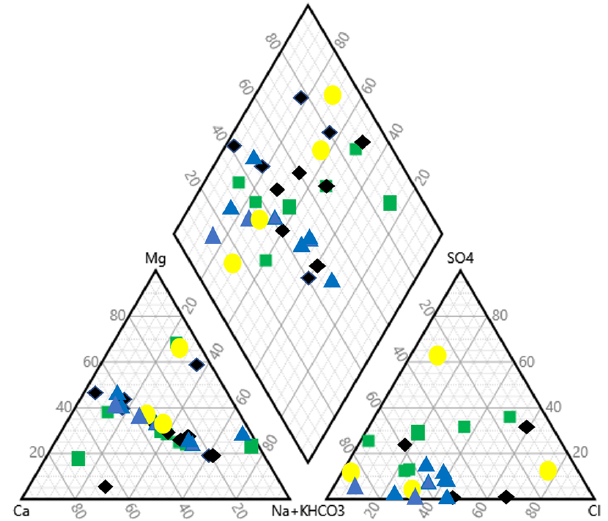
Figure 6. Piper diagram for the data collected in the sampling site, using HydroOffice software. Coloured in green the samples form Quinto di Treviso, in black samples from Treviso, in light blue sam- ples from Preganziol and in yellow samples from